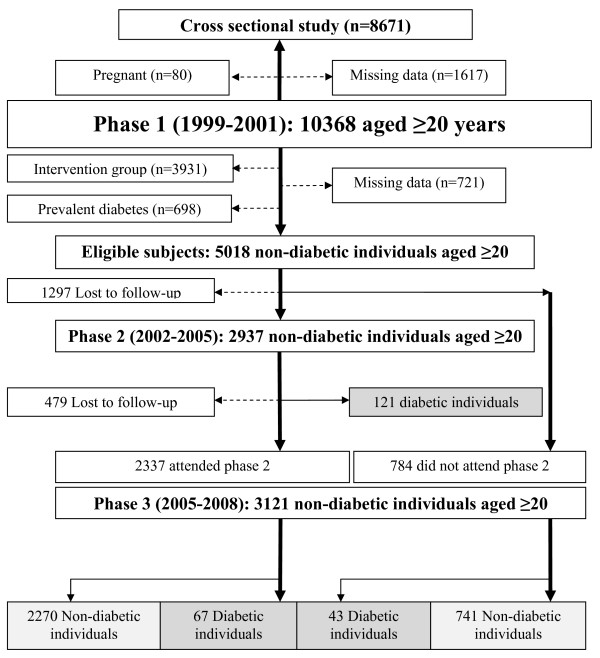
Study population: included, excluded, lost to the follow-up and events, and censored individuals. Starting point is black text-box with upward, for cross sectional study; downward, for longitudinal study.